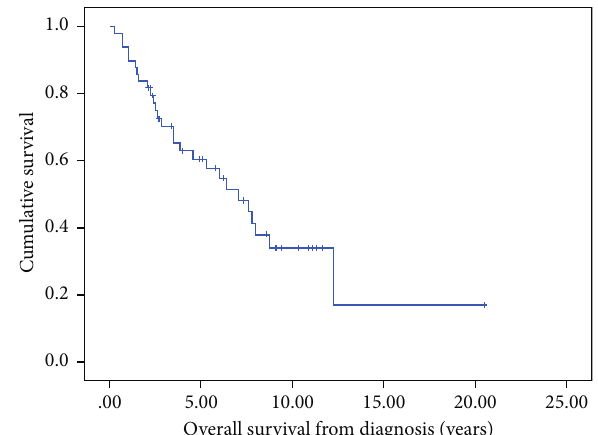
Figure 2: Kaplan–Meier curve of overall survival from date of